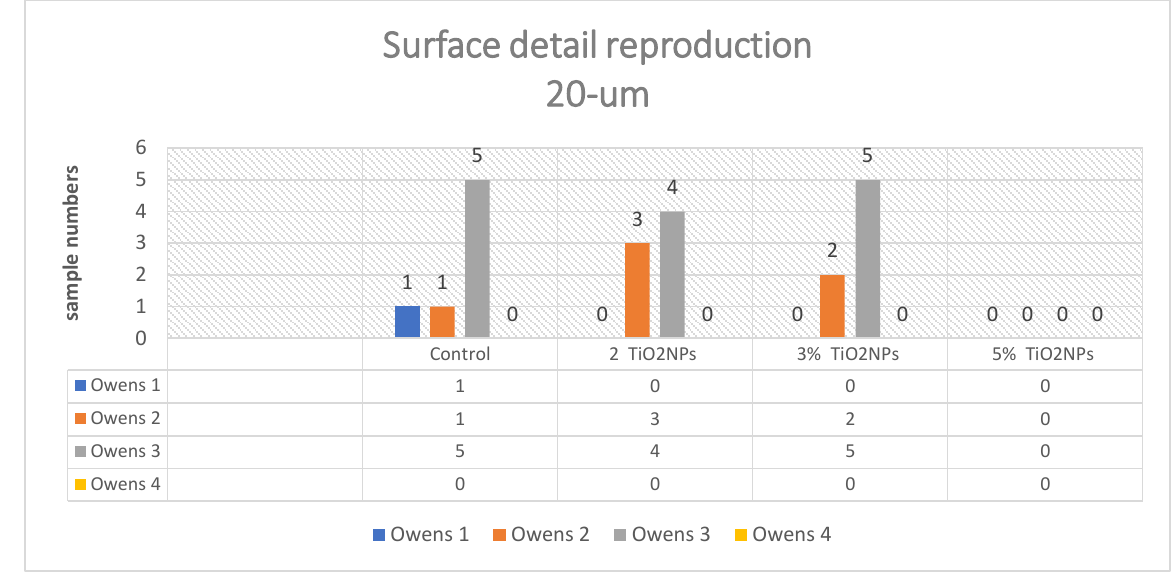
Figure 5 : Surface detail